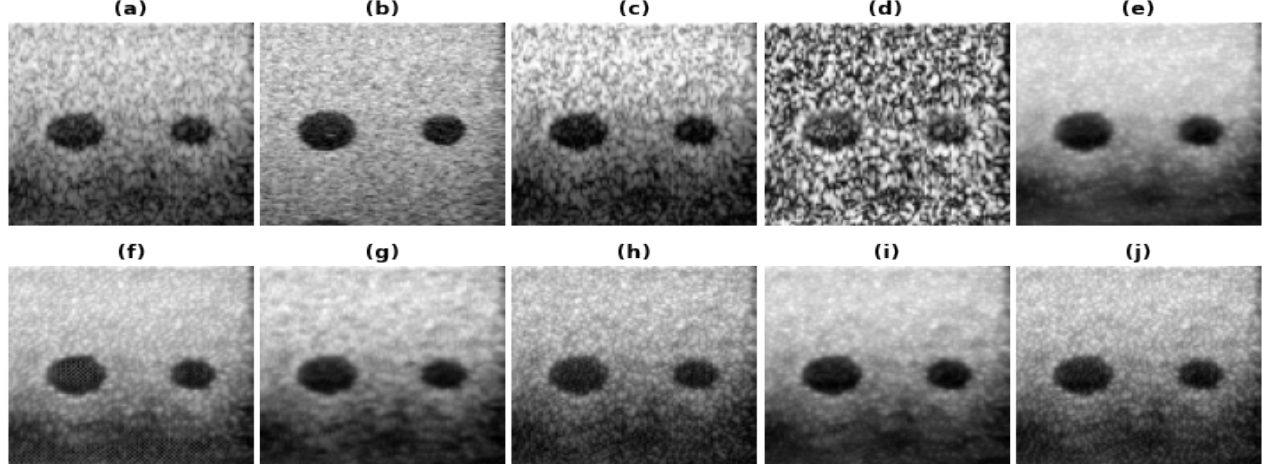
Figure 6. Results of the bandwidth improvement for Commercial phantom for different models ( a ) Band-limited image ( b ) Full Bandwidth image ( c ) Histogram Equalization ( d ) Contrast Limited Adaptive Histogram Equalization ( e ) U-Net-PL1 ( f ) U-Net-PL2 ( g ) SRCNN-PL1 ( h ) SRCNN-PL2 ( i ) REDNet-PL1 ( j )